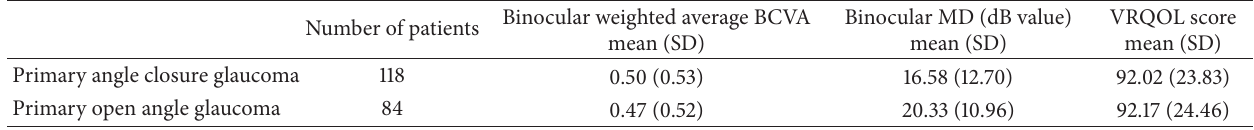
Table 4: Visual function score of different glaucoma type groups.